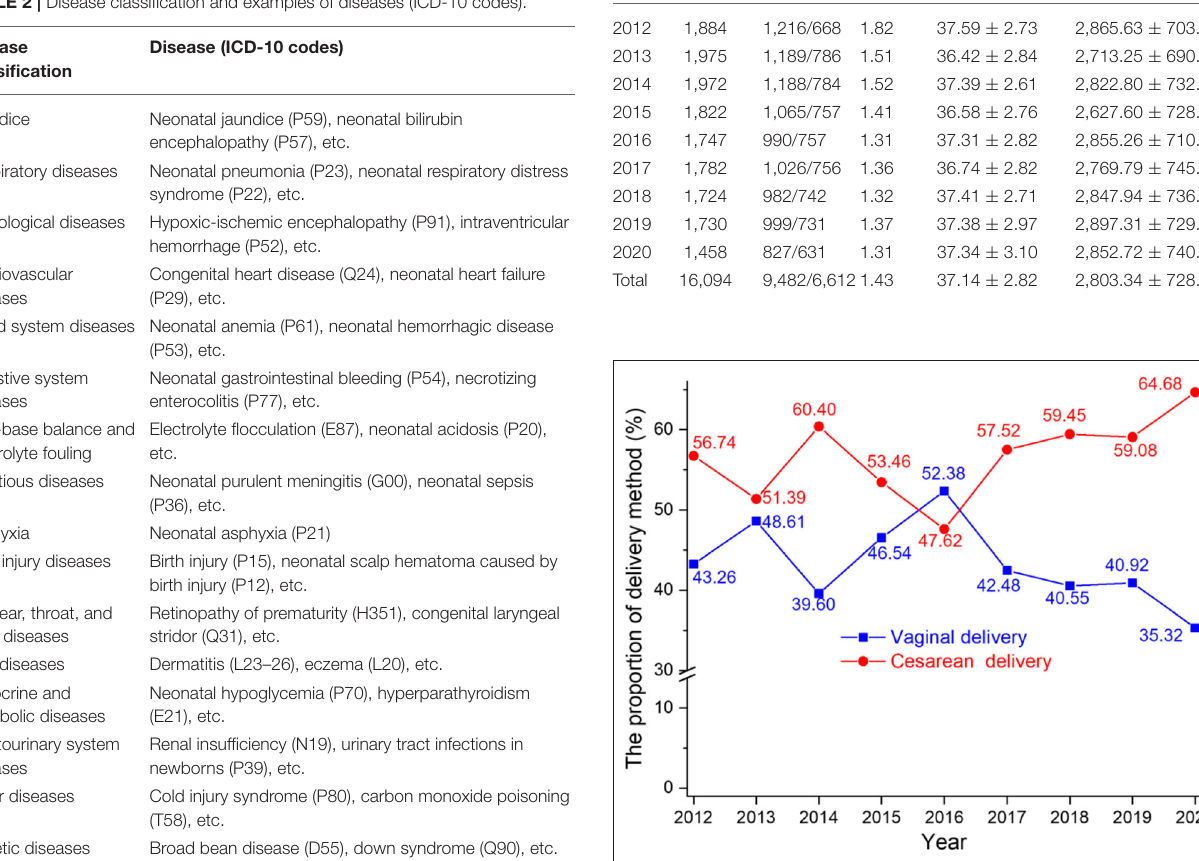
FIGURE 2 | The proportion of vaginal delivery and cesarean delivery from 2012 to